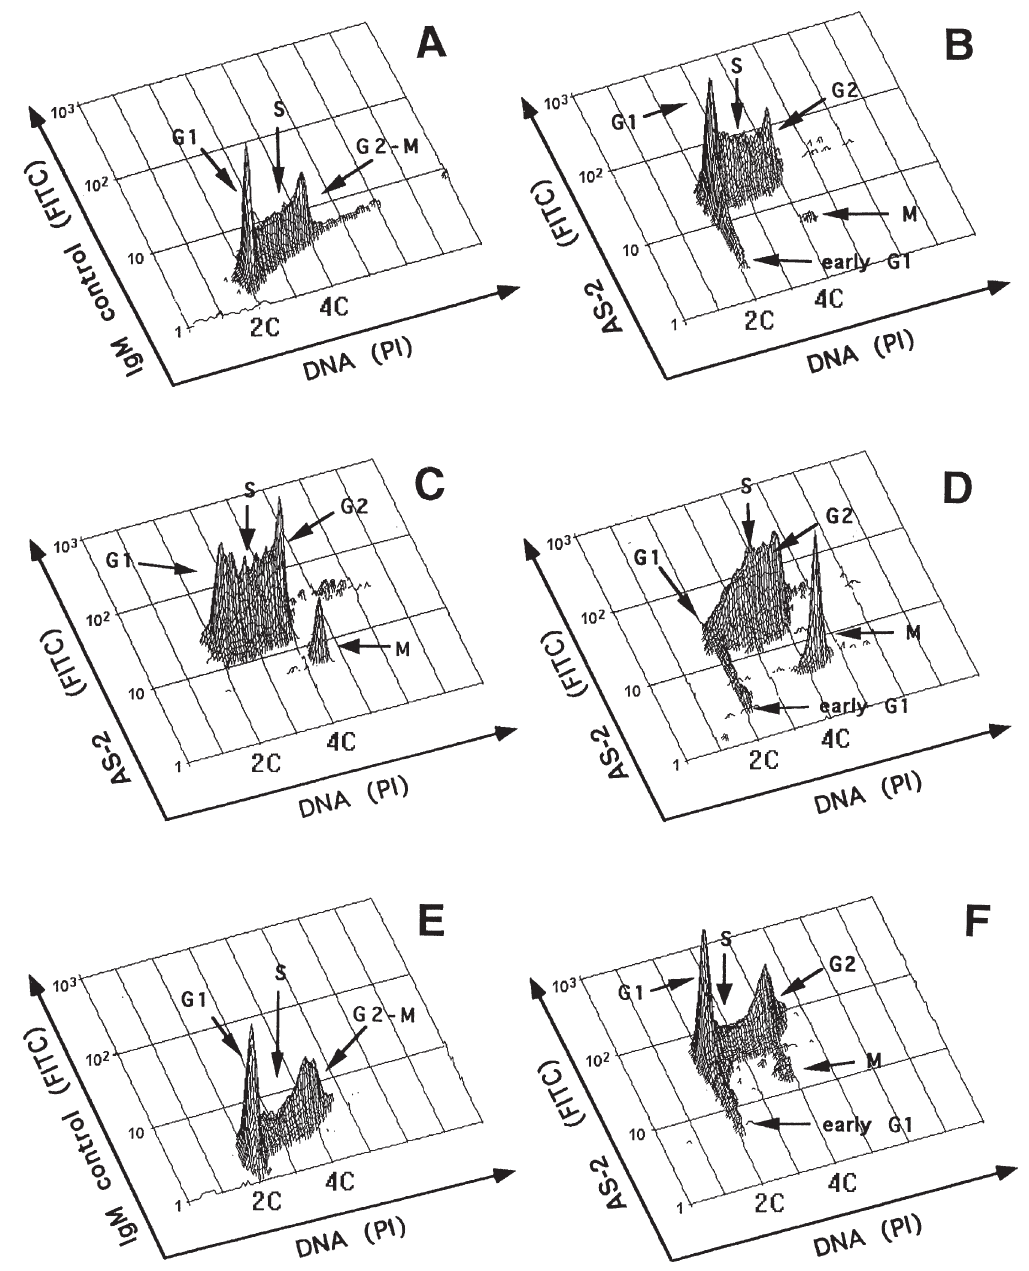
Fig. 4. Multiparameter flow cytometric analysis of the proteins recognized by the AS-2 antibody. FITC-green fluorescence values (logarithmic scale) are shown versus PI-red fluorescence values (linear scale) proportional to DNA content. Data shown are for fixed nuclei suspensions ((A)–(D)) and for whole fixed cell suspensions ((E) and (F)). Negative controls were obtained by means of unspecific IgM and secondary FITC-conjugated Mabs either for nuclei suspension (A) and for cell suspensions (E). The AS-2 protein distribution in nuclei extracted from exponentially growing cells is reported in (B). AS-2 protein distribution in nuclei from cells harvested 2 h after treatment with colcemid at 0.1 (cid:22) M concentration (C) and 2 h after colcemid release (D) is shown. AS-2 related fluorescence in exponentially growing cells is shown in (F). Cell cycle phases are indicated by